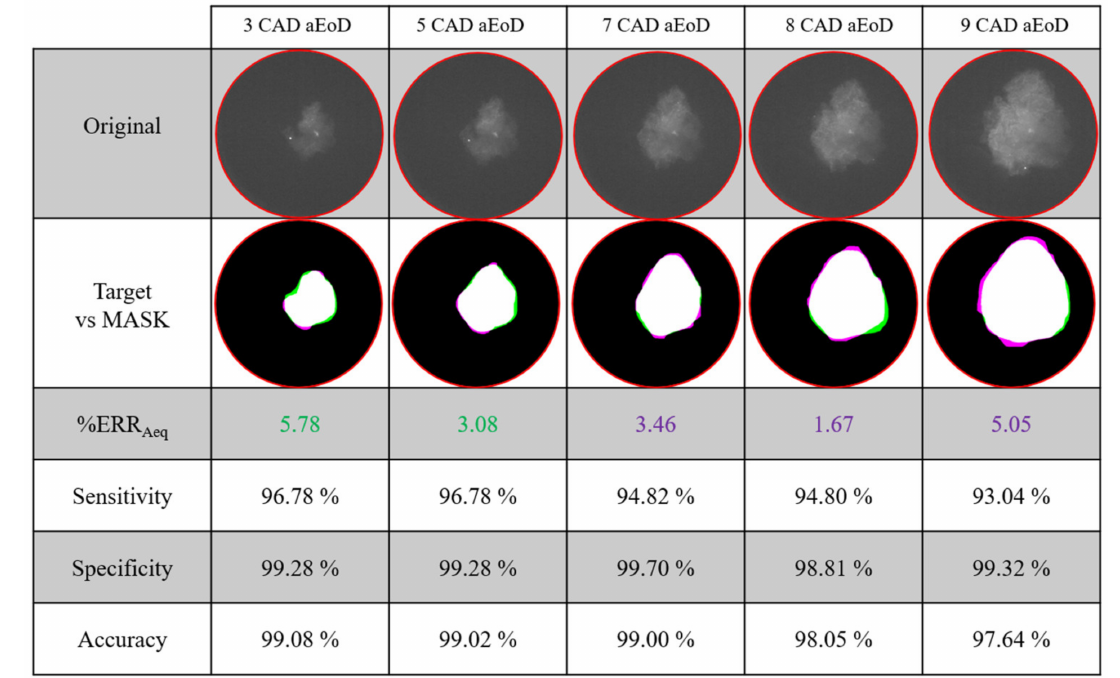
Figure 7. Qualitative and quantitative comparison, at different CAD after the end of the discharge, between the original images and the output of Mask R-CNN, made out to evaluate the effectiveness of the proposed method. Overestimation of the flame front are indicated in green while underestimation in